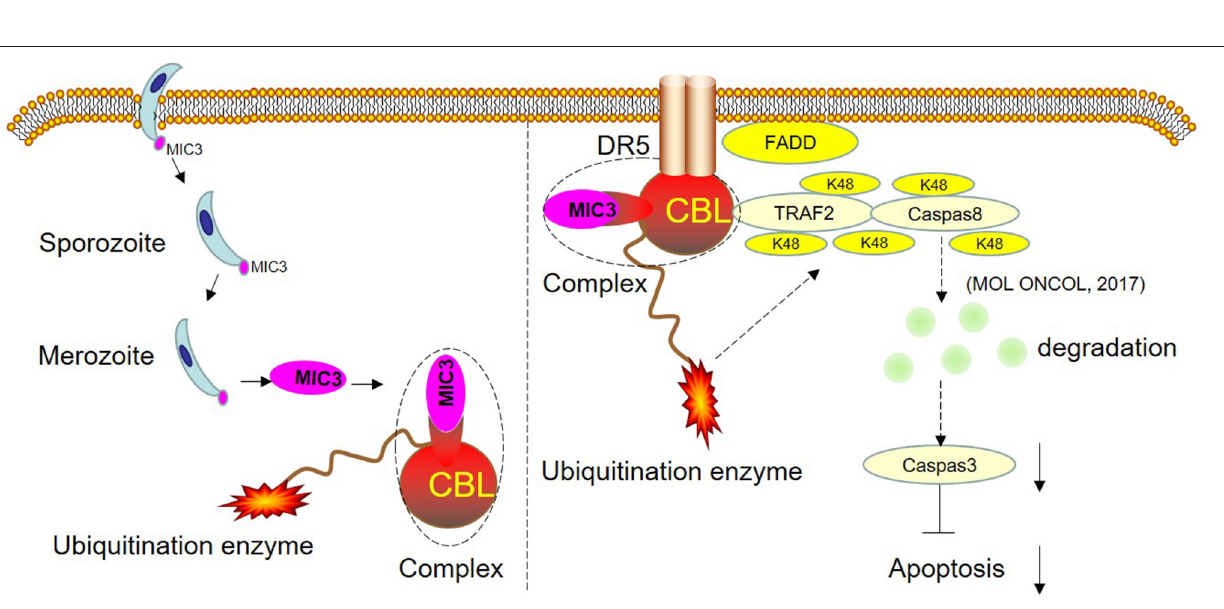
FIGURE 6 | Schematic representation of the proposed model. CBL and EaMIC3 form a complex in chick duodenal epithelial cells. Overexpression of CBL inhibits duodenal epithelial cell apoptosis, while interference of CBL expression promotes apoptosis. CBL are the critical adaptors linking DR5 and TRAF2. TRAF2 mediates the K48-linked polyubiquitination and degradation of caspase-8, which blocks the apoptosis. The shRNA targeting CBL inhibits TRAF2-mediated K48-linked polyubiquitination and degradation of caspase-8, which leads to the induction of apoptosis. The MIC3 inhibits apoptosis of the chick duodenal epithelial cell by targeting